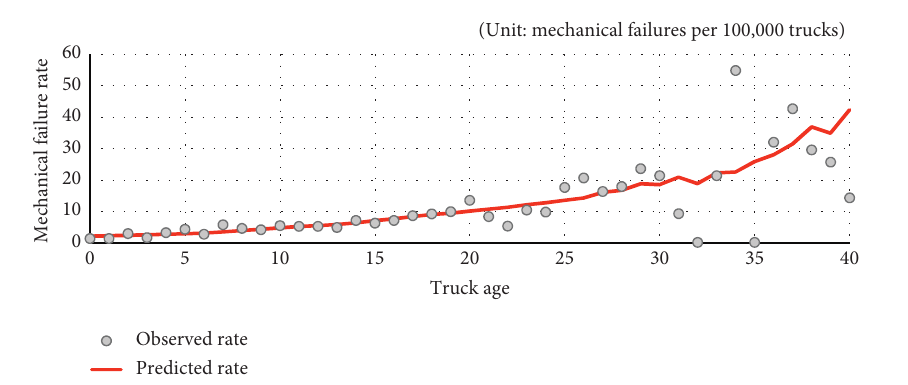
Figure 2: Mechanical failure crash rate by truck age.